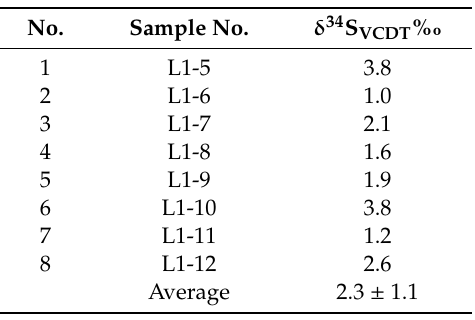
Table 2. The δ 34 S values of molybdenite from the Lyangar ores. No. Sample